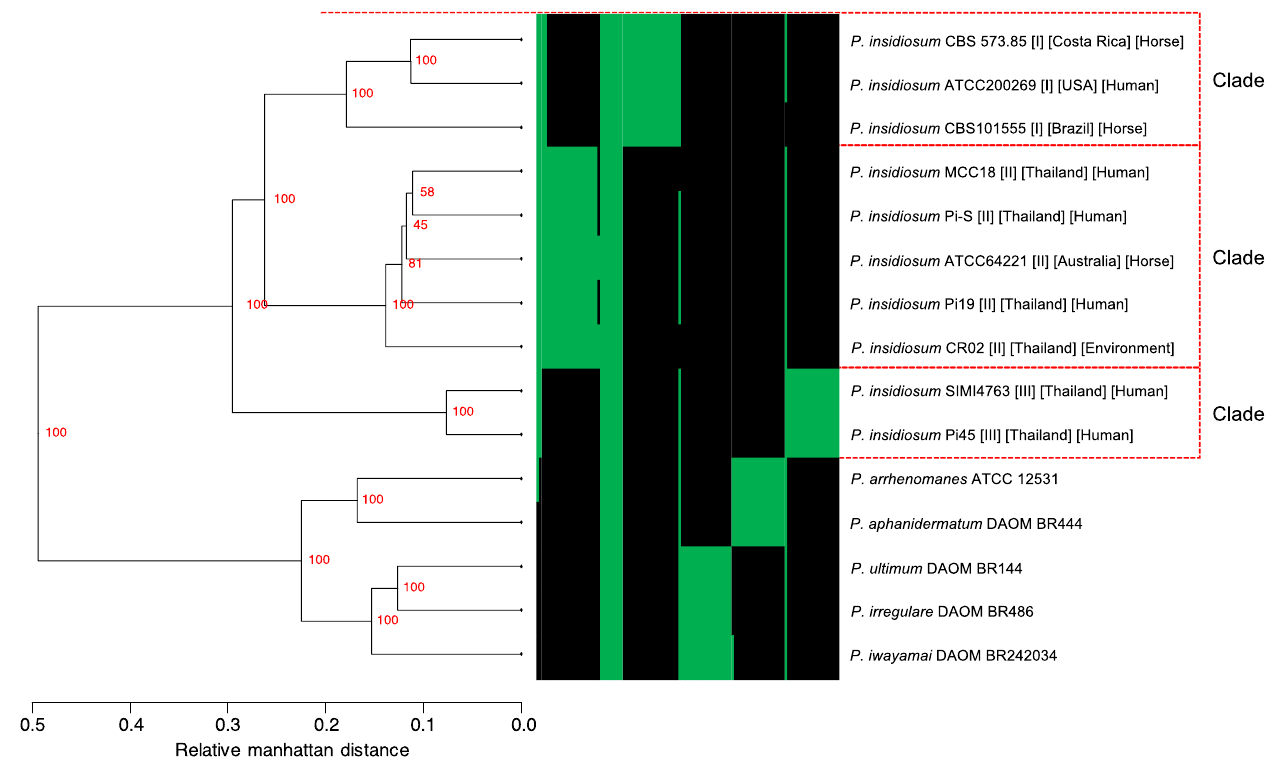
Figure 3. A dendrogram showing the hierarchical clustering result based on 45,801 gene-presence profiles across 10 P. insidiosum strains and 5 Pythium species. The presence (green) or absence (black) status of 120 selected genes are shown as a heat map next to the dendrogram. The bootstrap values are shown on each dendrogram branching node. Red boxes depict groups of the P. insidiosum strains assigned to rDNA-based genotype clades I, II, and III. This result shows that P. insidiosum strains from the same clade share higher gene-content similarity.